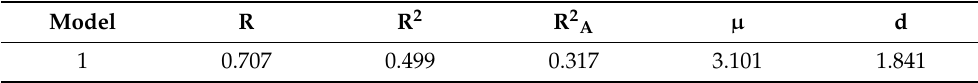
Table 7. The major parameters of the regression statistics for the multiple models of the functional relationship of digitalization factors and the coefficient of the company’s financial independence.